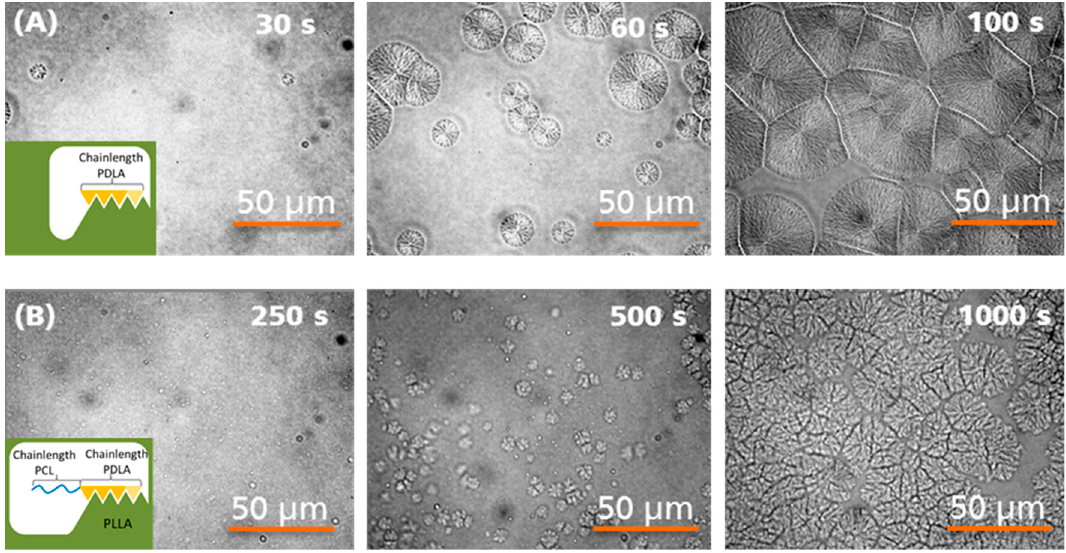
Figure 6. Thermo-optical analysis of blends from PLLA with ( A ) PDLA_5000 and ( B ) PDLA_5000_PCL_830.